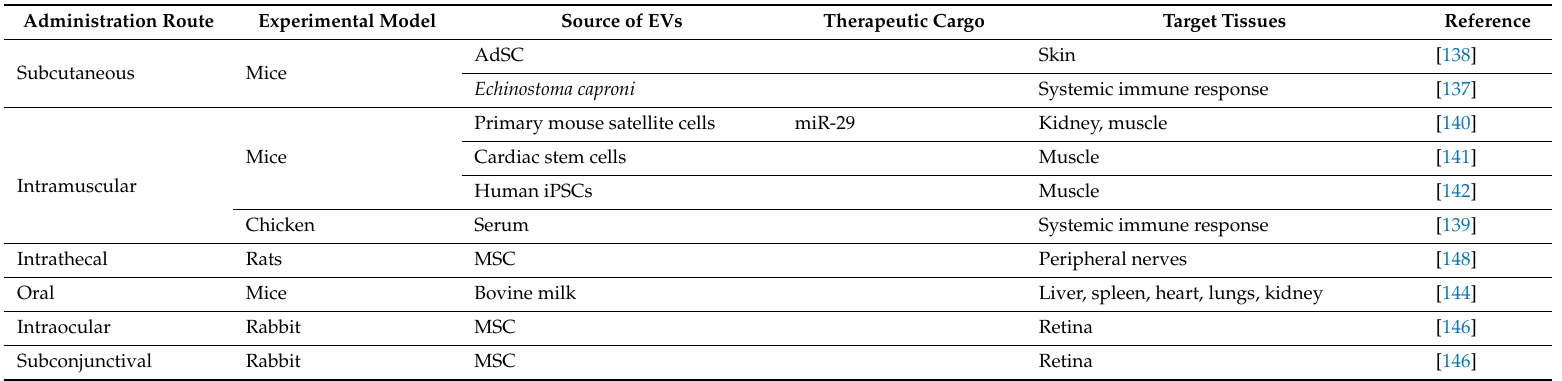
Table 2. Administration routes for EVs in vivo. Detailed are di ff erent studies using in vivo models where EVs were administered. Described are the administration routes, the experimental model, the source of EVs, the therapeutic cargo (when known), and the target tissue of the EVs or the EV-related e ff ects. While in some cases a therapeutic cargo was known, in other cases the EV itself was the therapeutic agent and no particular component of the cargo was specified as responsible for the e ff ect observed. Abbreviations: AdSC: adipose tissue-derived stem cells; CNS: central nervous system; miR: micro RNA; MSC: mesenchymal stem